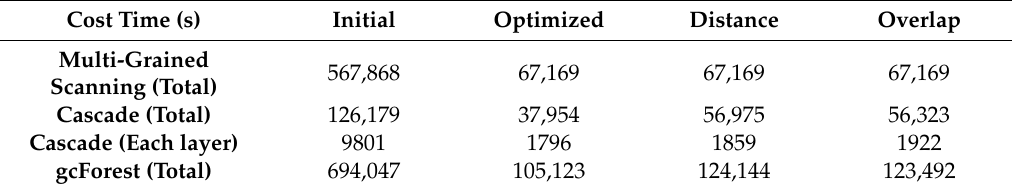
Table 17. Time consumption of each stage and each